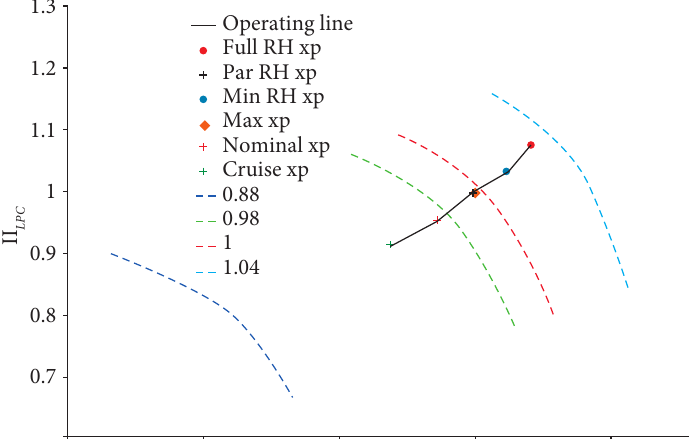
Figure 14. Characteristic maps with simulated operating line (shown in black). Also experimental operating points corresponding to different ratings are shown with markers.